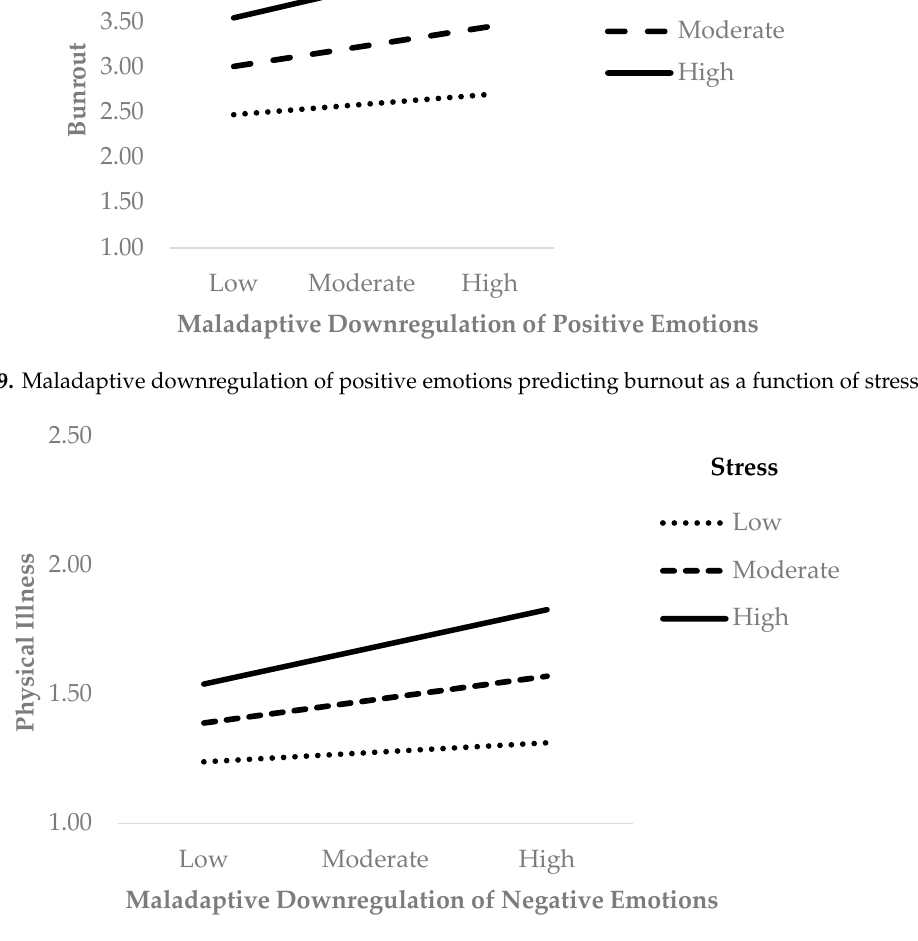
Figure 10. Maladaptive downregulation of negative emotions predicting physical illness as a function of stress.